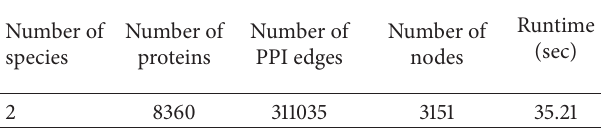
Table 9: The run-time results for pairwise alignment. Number of